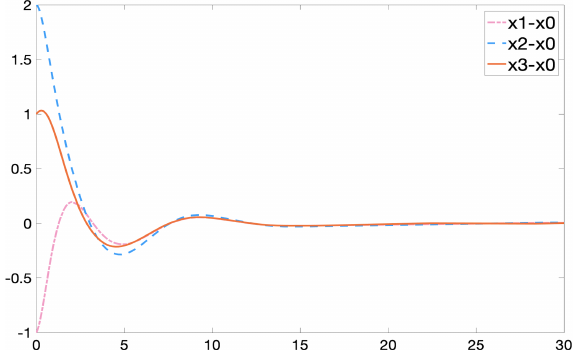
Figure 8. Errors between the displacement of three followers’ hanging points and that of Leaders’ hanging points.